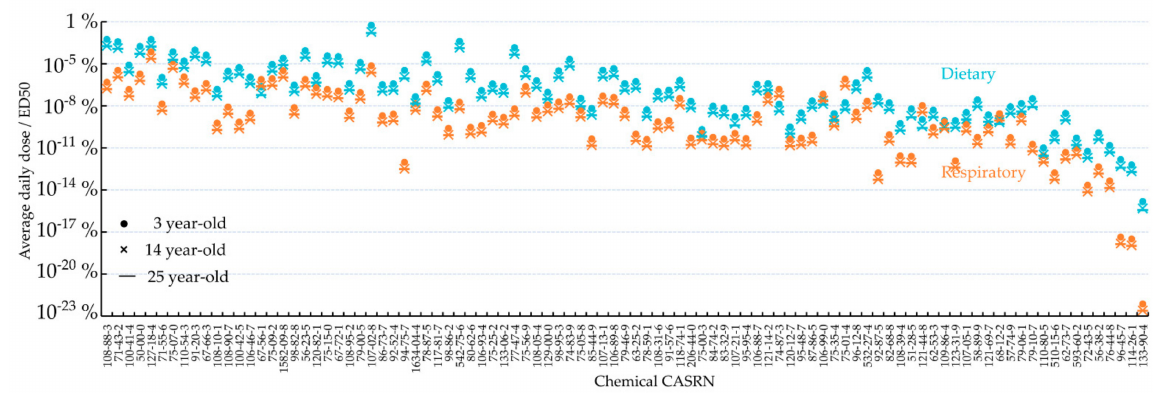
Figure 3. The ratio of the average daily dose to ED 50 for 95 organic chemicals (ingestion in blue and inhalation in orange) for 3-, 14-, and 25-year-olds predicted in this study based on background emission rates from NEI; the chemicals are ranked in the same order as in Figure